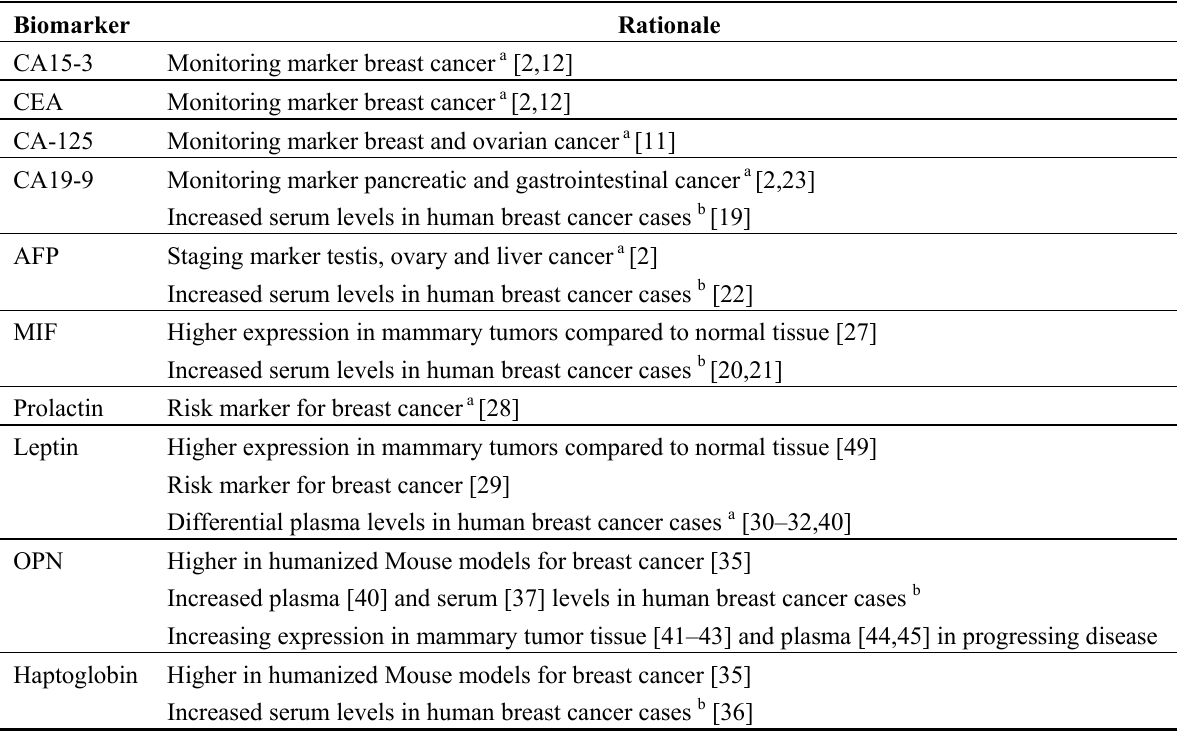
Table 1. List of biomarkers